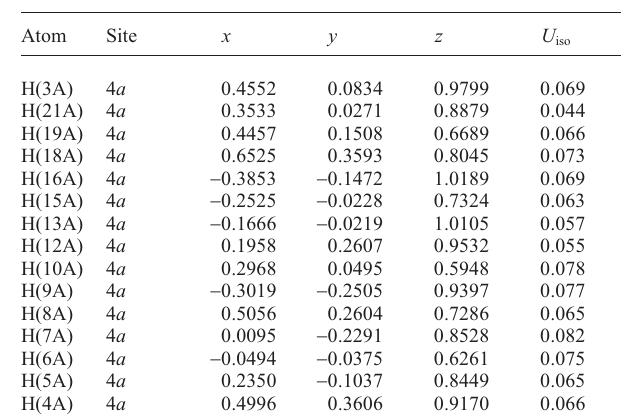
Table 2. Atomic coordinates and displacement parameters (in Å 2 )